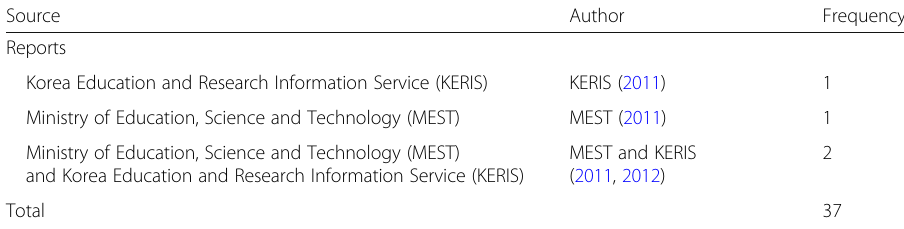
Table 2 Data sources listed by type, author, and frequency (Continued)